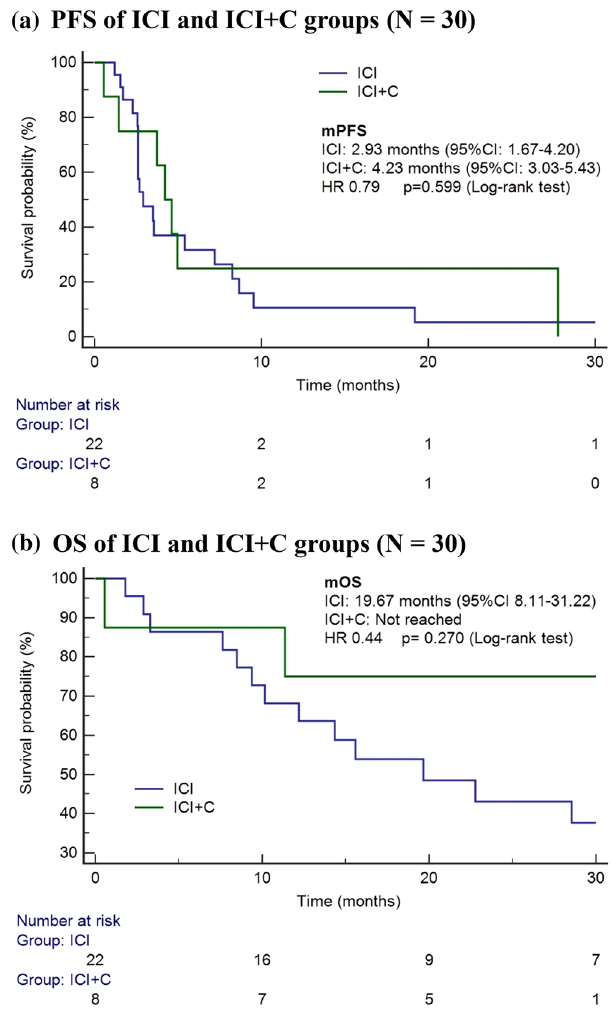
Figure 2. ( a ) PFS of ICI and ICI + C groups (n = 30). ( b ) OS of ICI and ICI + C groups ( n=